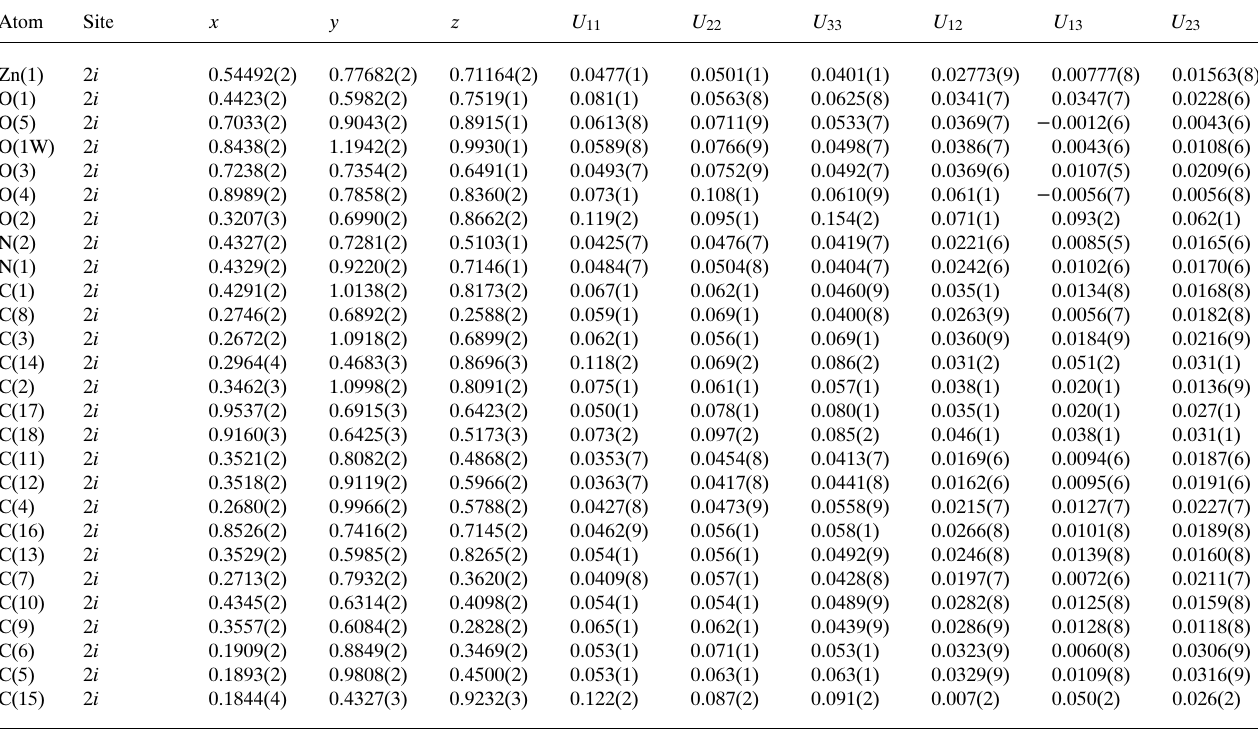
Table 3. Atomic coordinates and displacement parameters (in Å 2 ) .